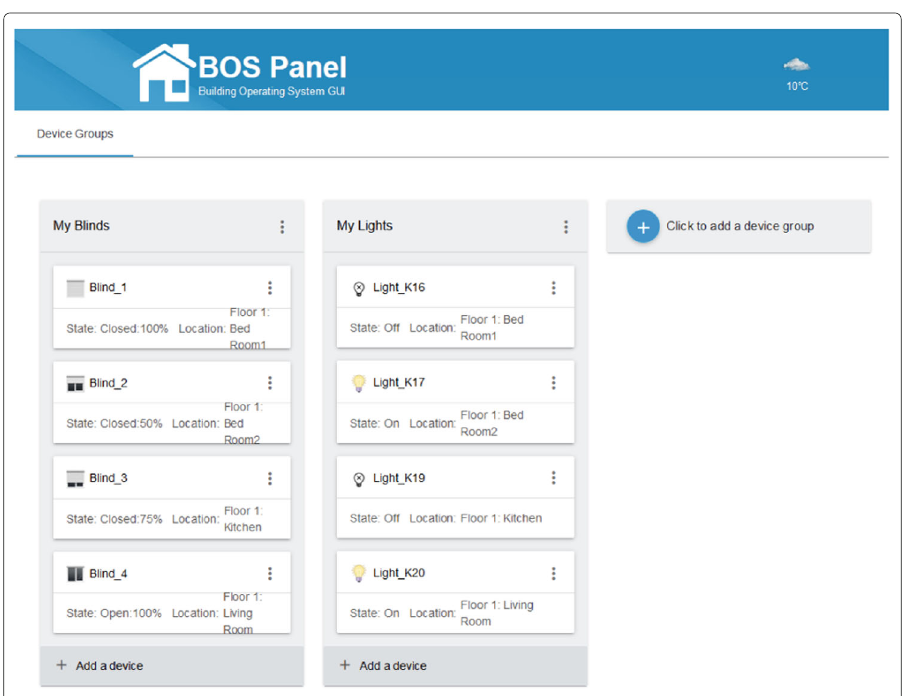
Fig. 18 BOS UI: customized device